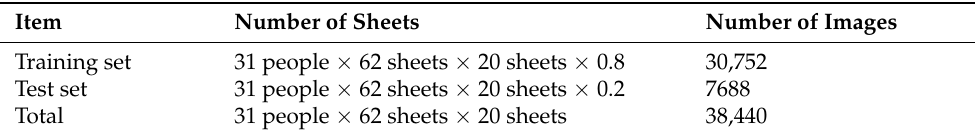
Table 3. List of images grouped in one of 7-groups (group-A+120--120E+00). Table 4. Number of images in training set and test set after data